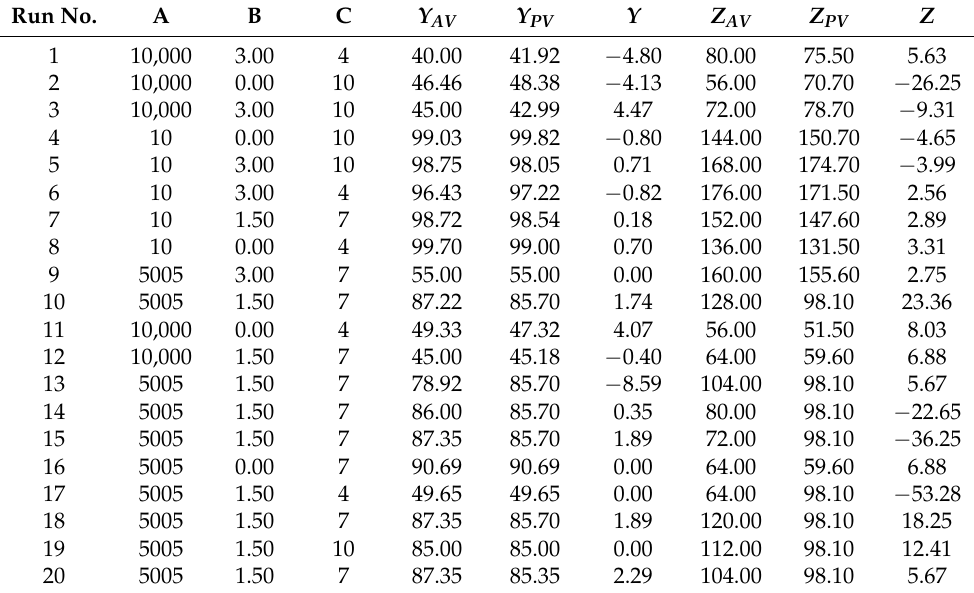
Table 2. Independent and process (dependent) variables of the experimental. Run